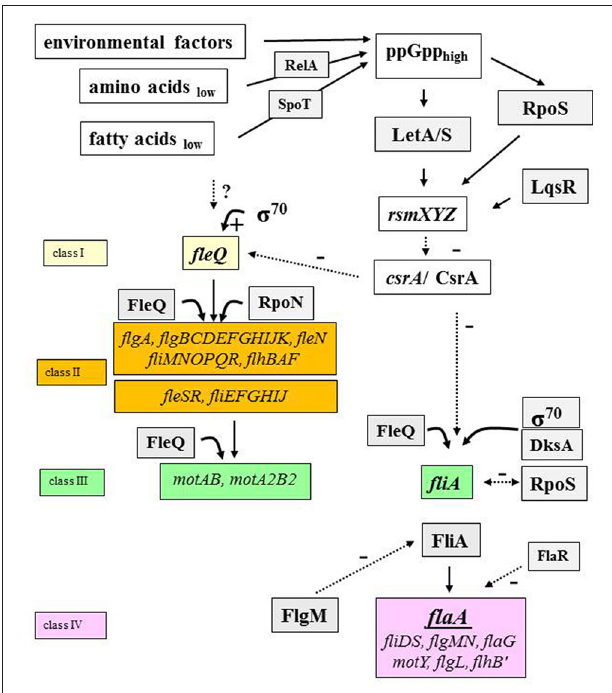
FIGURE 4 | The flagellar regulon cascade. The regulatory cascade which leads to the expression of proteins that are needed to construct a functional flagellum is shown ( Heuner and Albert-Weissenberger, 2008; Sahr et al., 2017, modified). Specific environmental factors lead to the activation of the pathway through alarmone (ppGpp) accumulation. Some main players of the flagellar regulon cascade are: the activator protein FleQ, the alternative sigma factor 28 (FliA), the two-component system (LetA/S) and the carbon storage regulator (CsrA) as examples. FleQ is the master regulator of the flagellar genes (Class II and class III). FliA is the regulator of flagellar genes of class IV. Black lined, continuous arrows refer to positive regulation events. The broken lines in black refer to negative regulatory effects of respective factors. Question marks (?) indicate pathway points with putative mode of actions that need to be specified by further investigations. RsmXYZ, regulatory RNAs; FlaA, flagellin; FlaR, transcriptional regulator (LysR family); FleQ and FleR, sigma factor